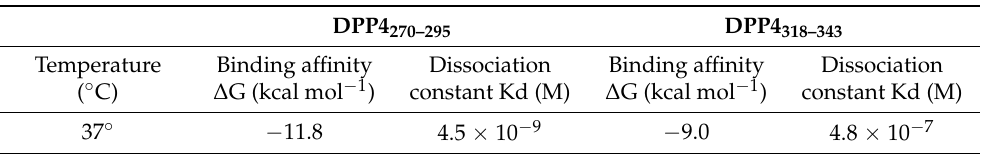
Figure 3. Key contacting elements inside ( a , b ) the RBD-up/DPP4 270–295 conformation, and ( c , d ) the RBD-up/DPP4 318–343 . Panels ( a ) and ( c ) show in stick representation all side chains involved in H-bonds (dark blue), π – π interactions (cyan), and salt bridges (purple). Panels ( b ) and ( d ) show the BSA area of RBD-up/DPP4 270–295 complex and RBD-up/DPP4 318–343 , respectively. The surface area of the peptides is shown in solid style and coloured according to the atom type. Table 3. Binding affinity of DPP4 270–295 and DPP4 318–343 in complex with S protein and their dissoci- ation constant (K D ) at 37 ◦